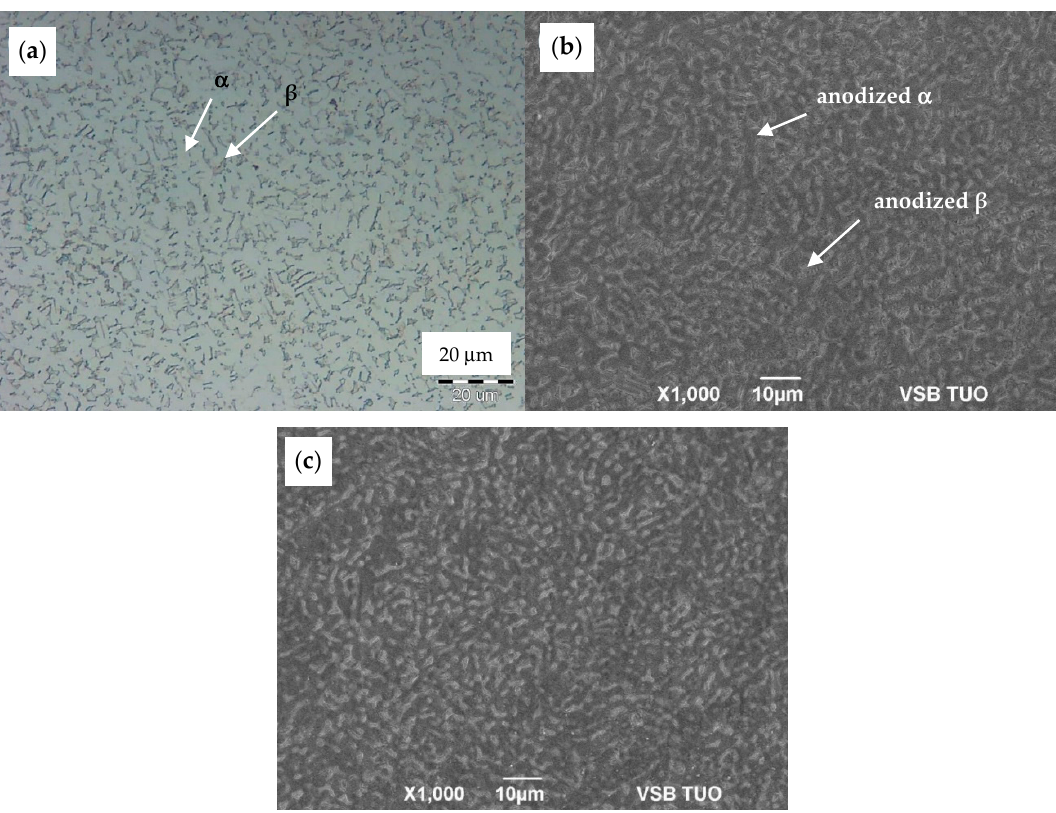
Figure 2. Comparison of: ( a ) OM microstructure of the substrate surface, ( b ) SEM SEI morphology of the as-anodized sample, and ( c ) SEM SEI morphology of the anodized-heat treated sample.